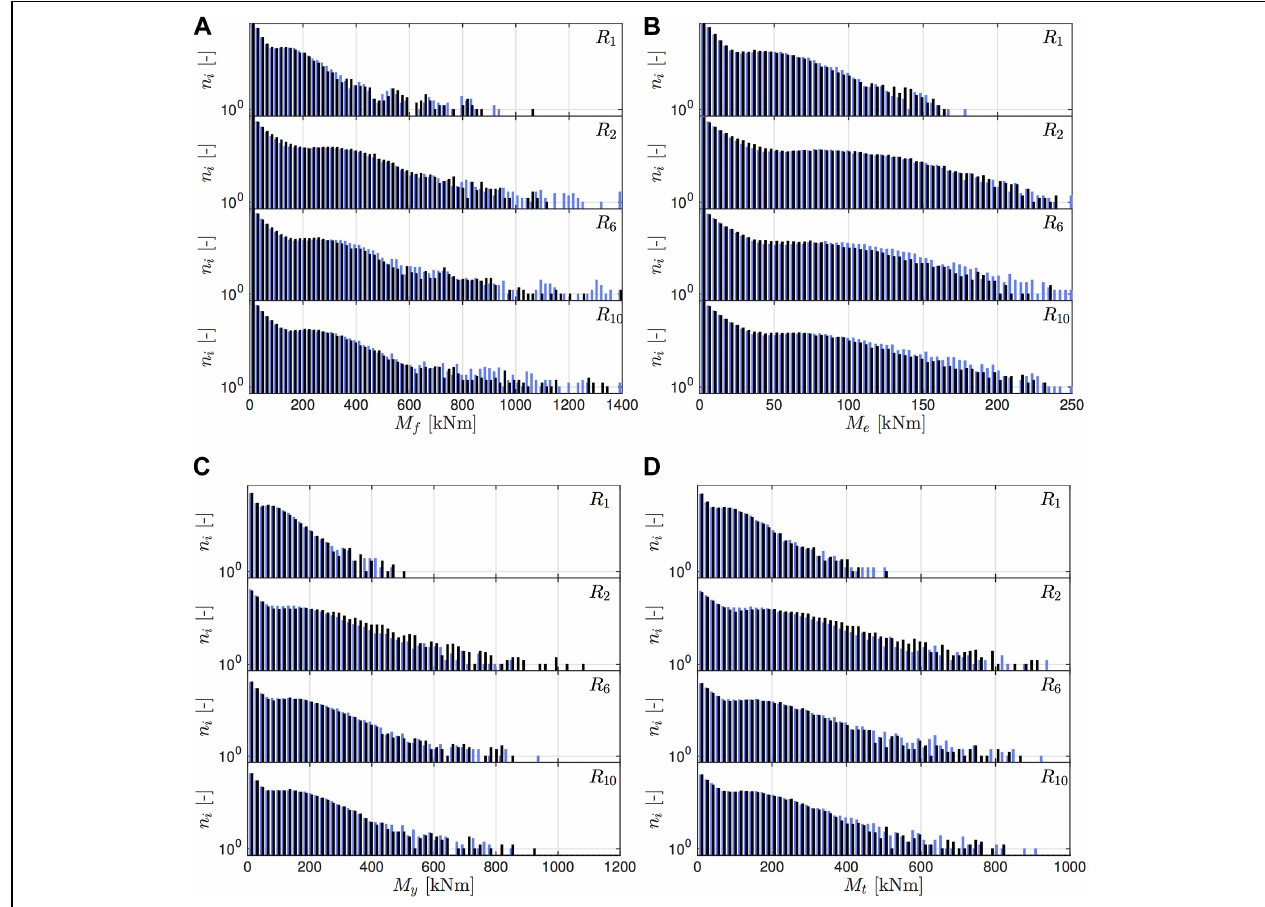
FIGURE 9 | Number of cycles for the flapwise (A) and edgewise (B) root bending moments and for the yaw (C) and tilt (D) moments in the rows R 1 , R 2 , R 6 , and R 10 , for α w = 262° (blue bars) and α w = 270° (black bars). For each row, the number of cycles is accumulated over six lines, from L 2 to L 7 .